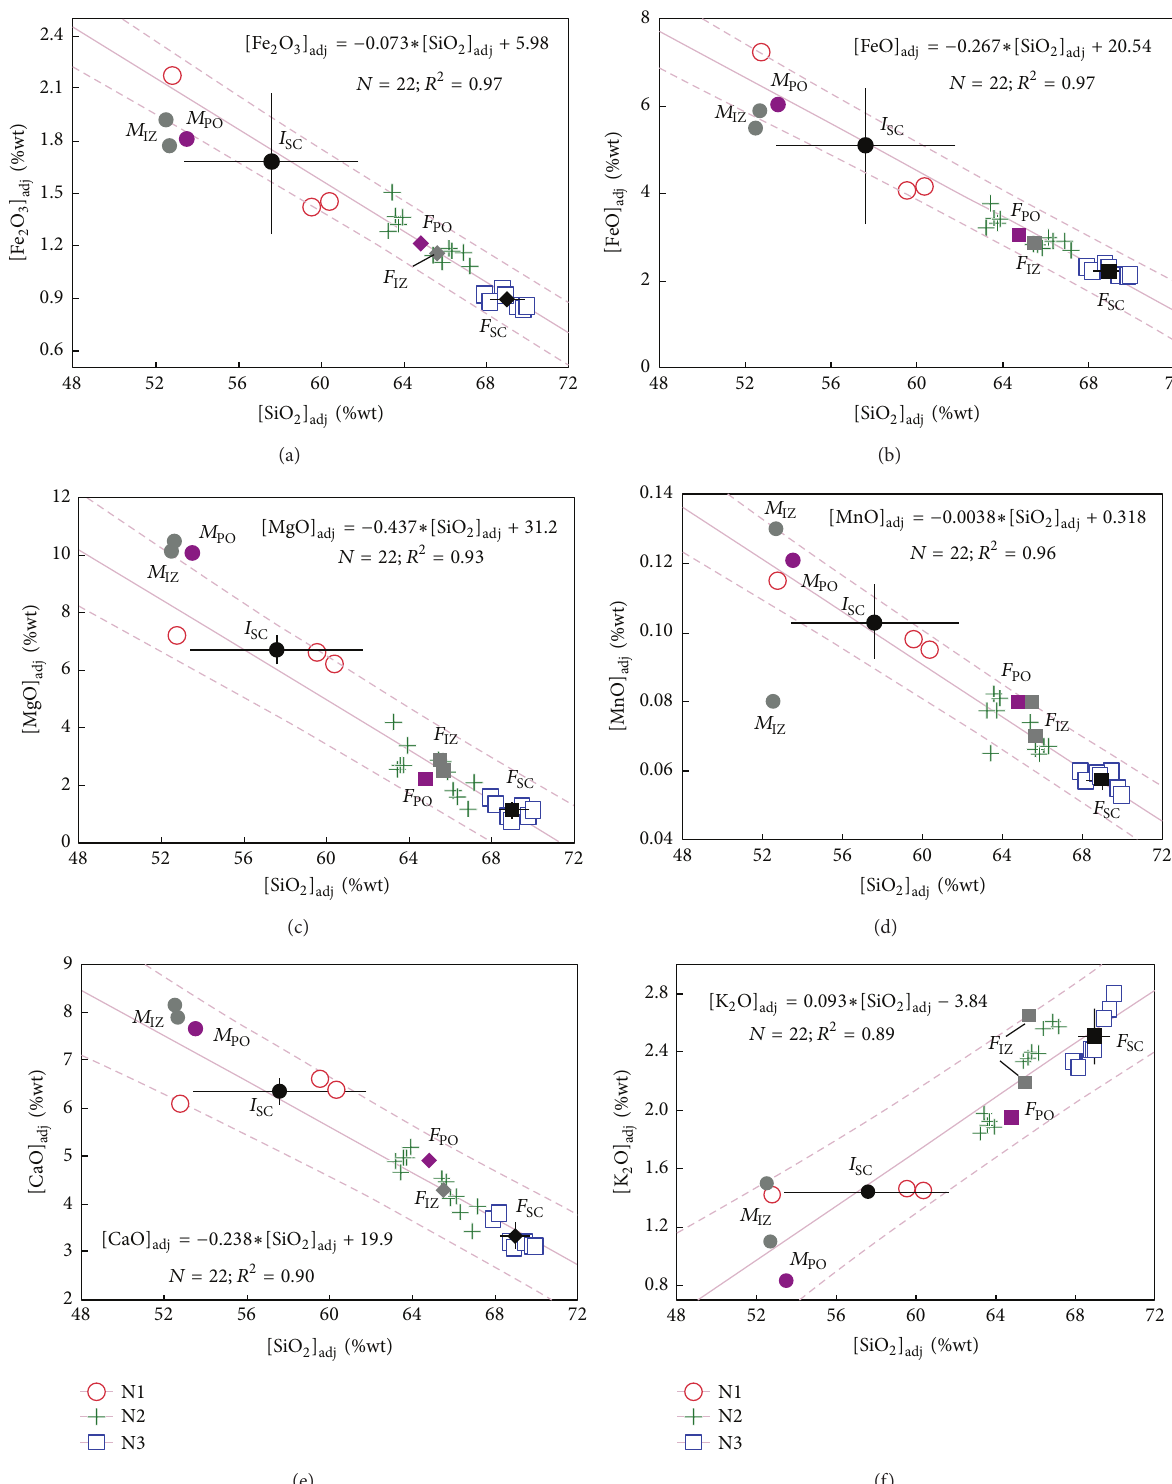
Figure 11: Major element Harker-type diagrams for volcanic rocks from the Sierra de las Cruces northern sector. An ordinary least-squares (OLS) regression model is included in each diagram (OLS equation; 𝑁 is number of samples; 𝑅 2 is Pearson regression coefficient; solid line is OLS model; discontinuous lines are 95% confidence regression bands). Abbreviations for end-members in mixing/mingling models: (a) : intermediate and 𝐹 : felsic; (b) Iztacc´ıhuatl volcano [31]: 𝑀 Sierra de las Cruces : 𝐼 SC SC 𝑀 : mafic and 𝐹 : PO PO